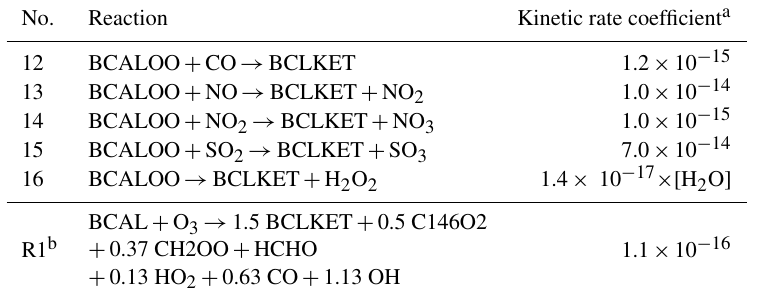
Table 2. Reactions before and after the jumping strategy, where the MCM species BCALOO is jumped over by its degradation product BCLKET. No.